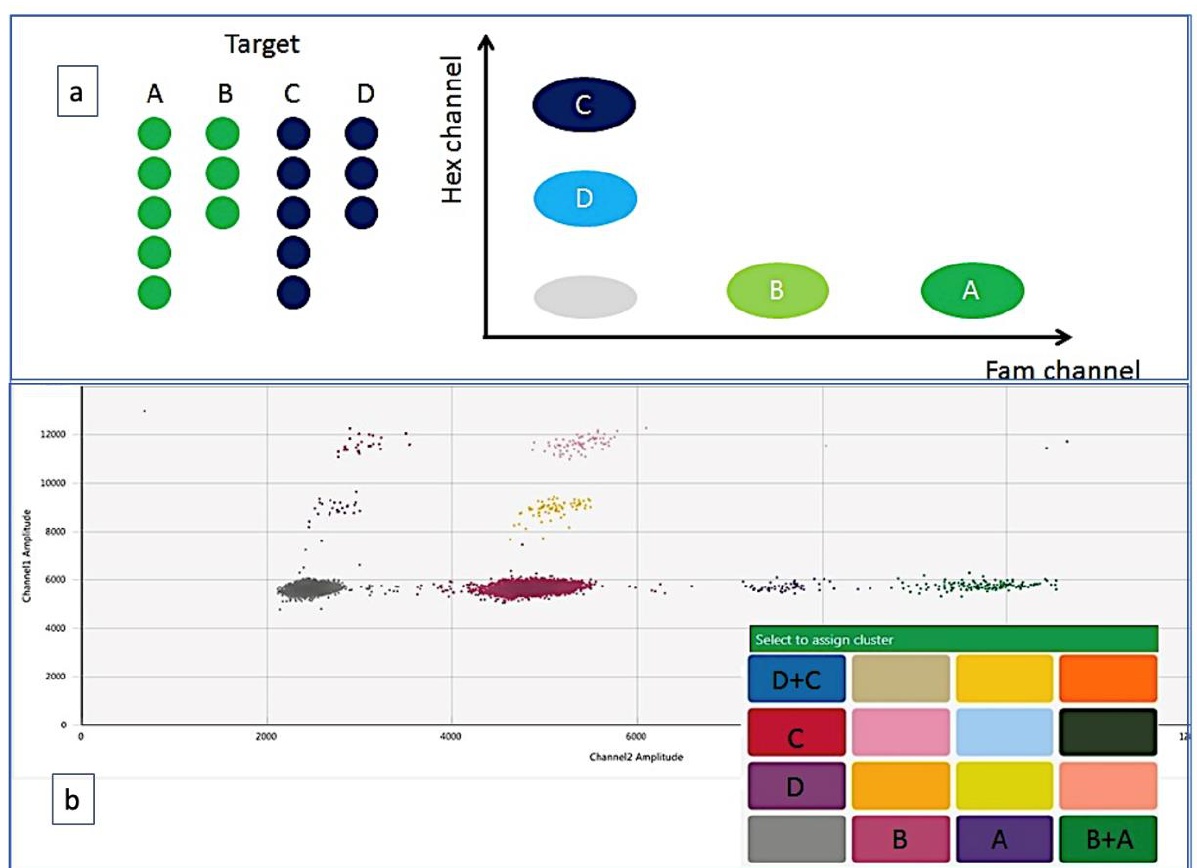
Figure 2. Multiplex assay based on the amplitude of the amplifiers. ( a ) the different targets are detected by probes labeled with the same fluorochrome (FAM or HEX) but used at different concen- trations. This strategy allows to quantify four targets within a single reaction (A, B, C, D). ( b ) Targets A and B have relative concentrations of 100% and 50% of FAM-labeled probe, respectively, while C and D have relative concentrations of 100% and 50% of HEX-labeled probe. In the 2D plot, 16 possible clusters are generated: clusters that contain only one target, clusters that simultaneously contain two targets and possibly clusters that contain three targets.